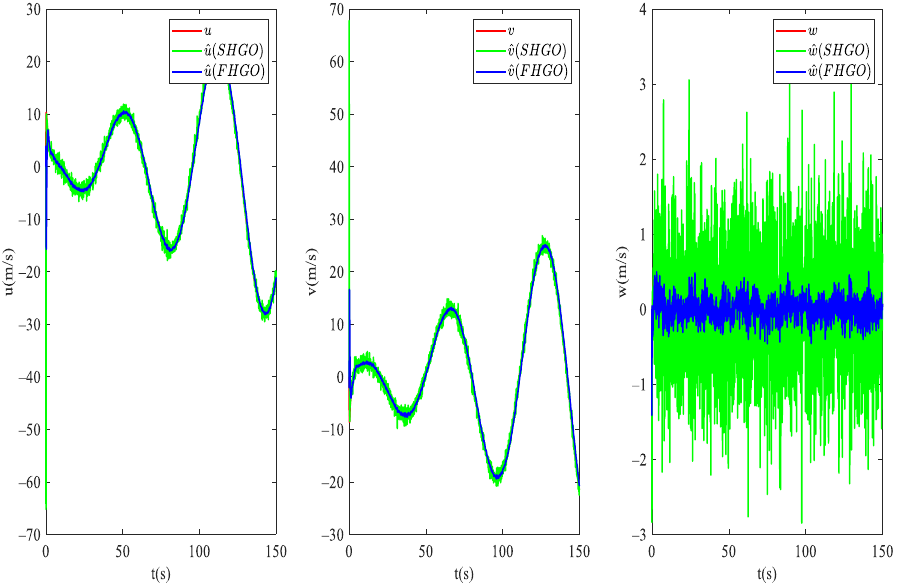
Figure 4. Velocity state estimation of state observer.